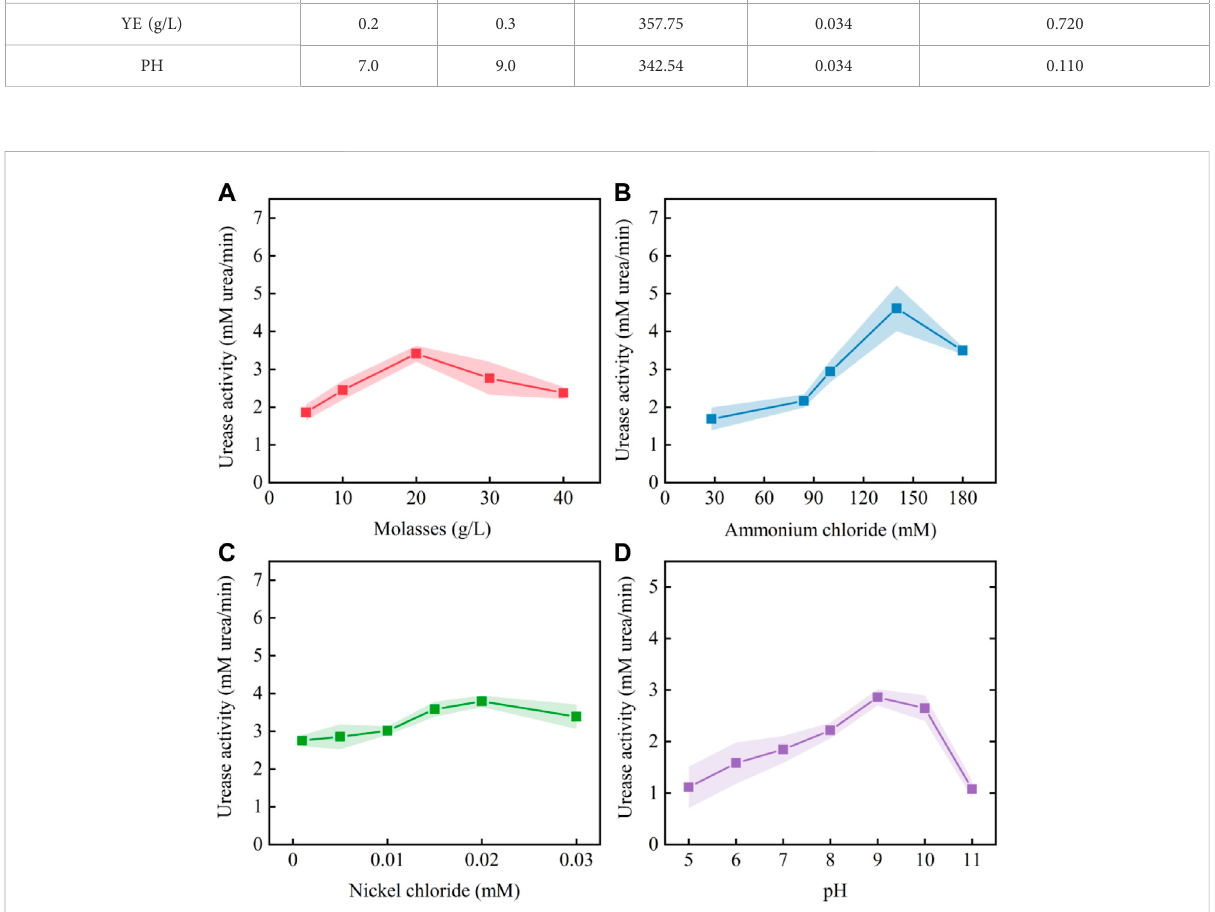
FIGURE 6 Effect of each key factor on urease activity: (A) molasses; (B) ammonium chloride; (C) nickel chloride; and (D)